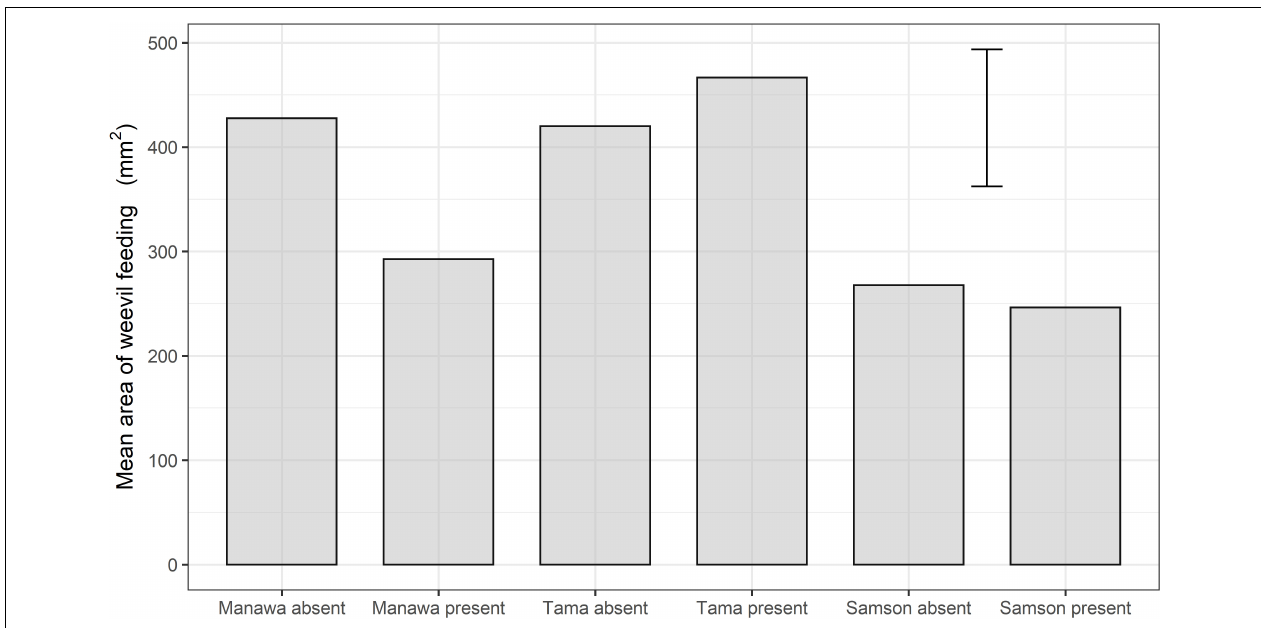
FIGURE 3 | Mean feeding area (mm 2 ) by the weevil L. bonariensis on Manawa, Tama, and Samson Lolium grasses in the absence or presence of the parasitoid M. hyperodae . The histogram shows the mean and an error term based on Fisher’s unprotected least significant differences